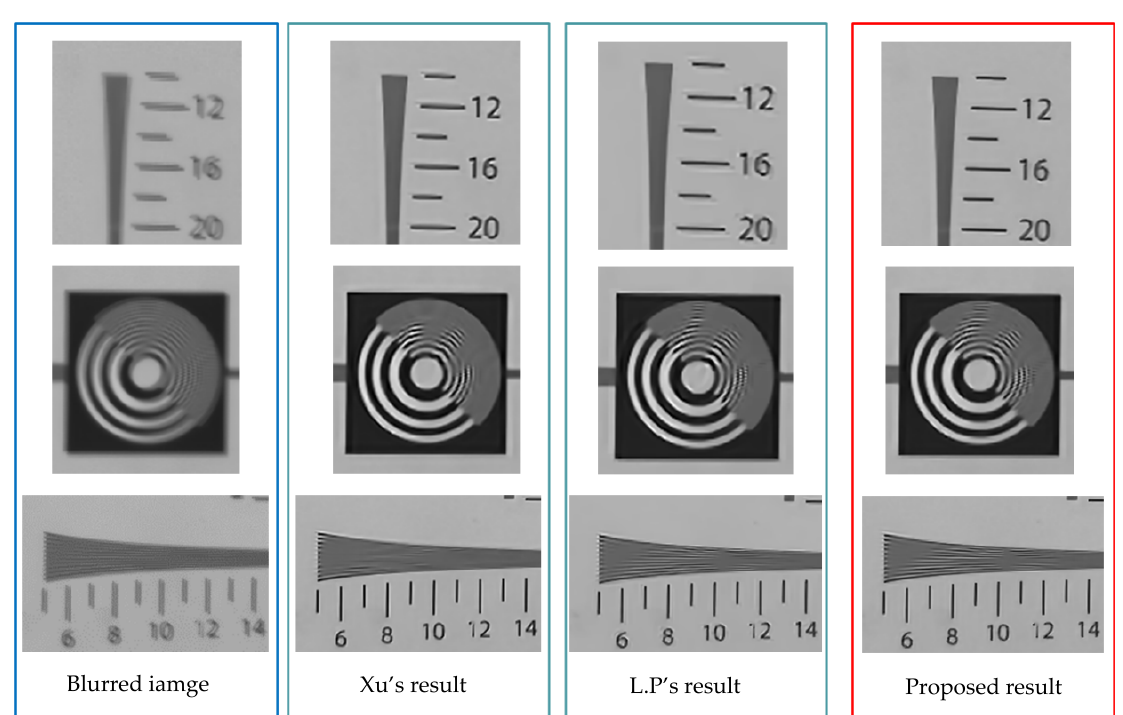
Figure 12. Details of results from the green box in Figure 9: From left to right: blurred image, Xu‘s result, L.P’s result, the proposed result. Table 7. Final results of the IQA.